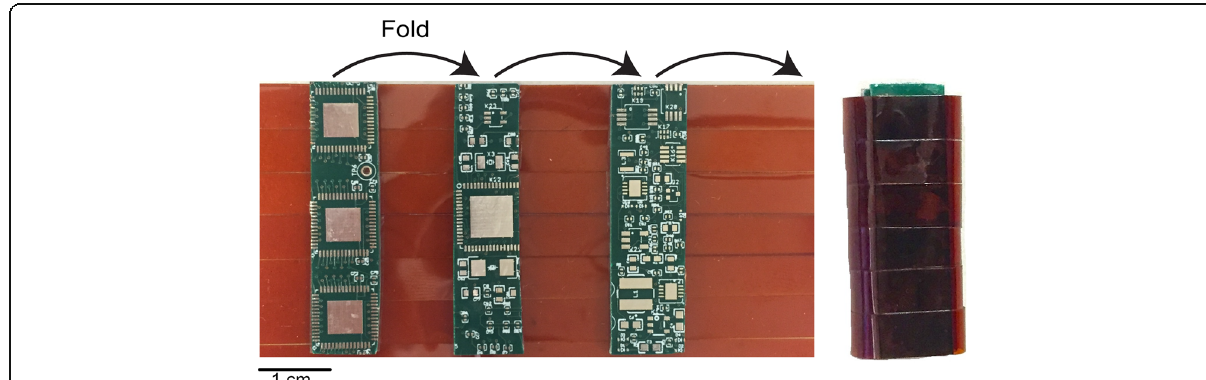
Fig. 4 (Left) Example mockup of final design with flexible circuitry. (Right) Demonstration of folded board to fit within the NNP module